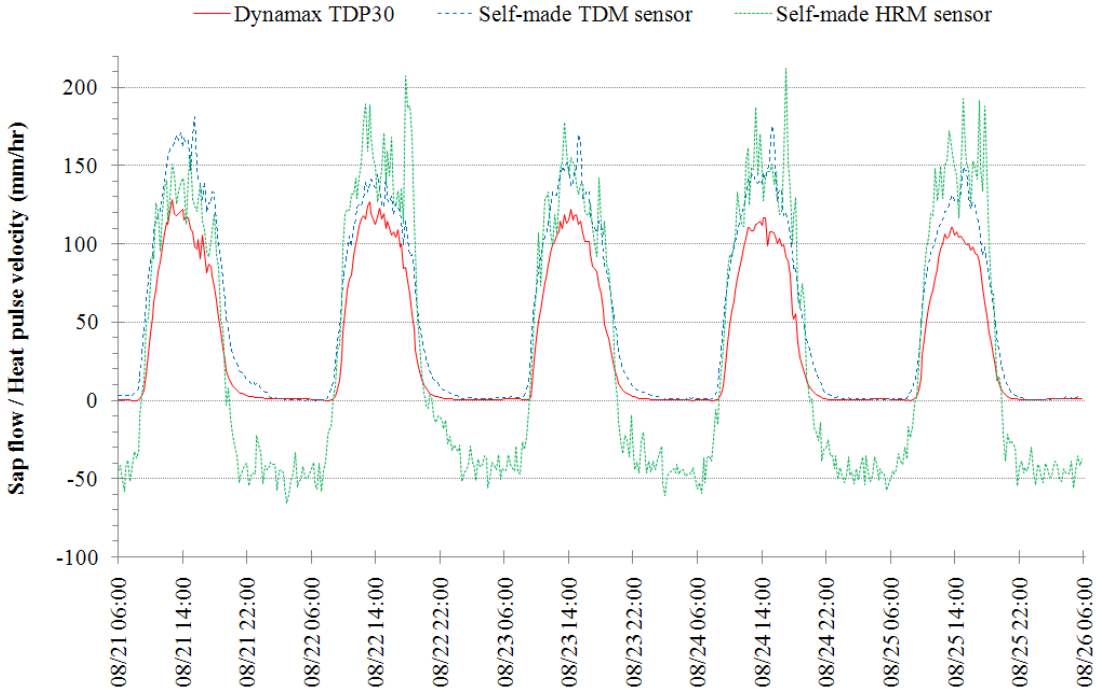
Figure 8. 21–26 August 2008 comparison of Dynamax TDP30 sap flow sensor (solid red line) to self-made TDM (dashed blue line) and HRM (dotted green line) sensors in a maple